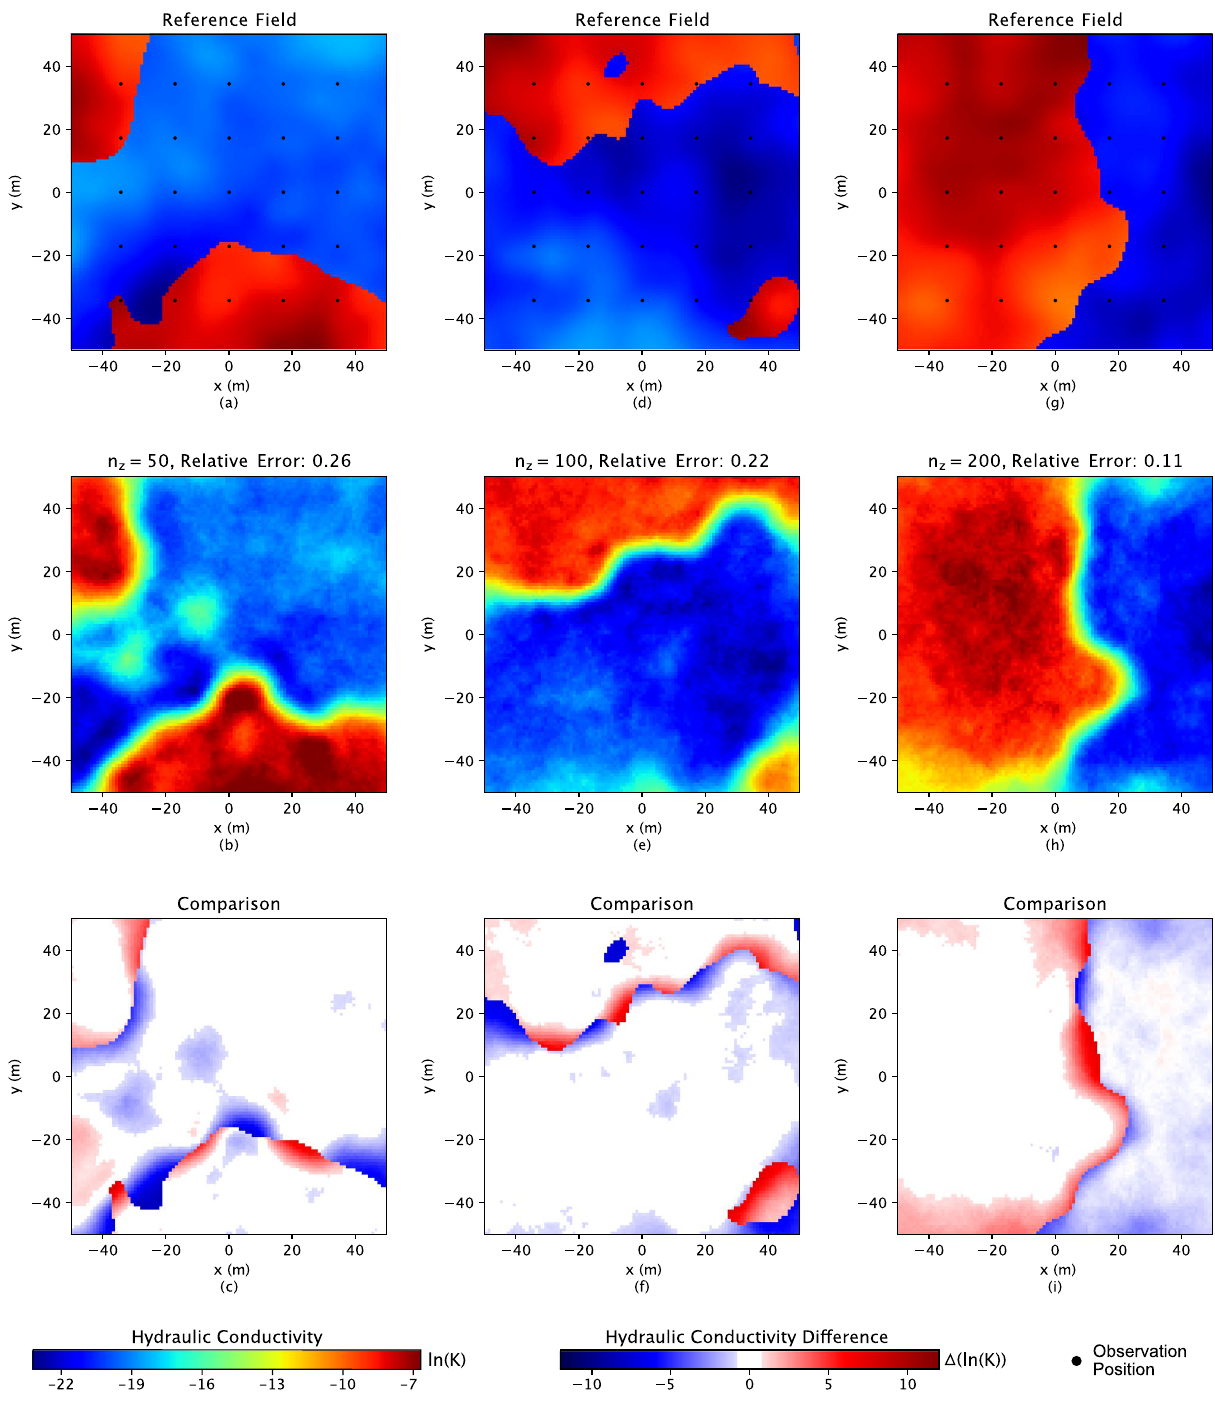
Figure 4. Three bimodal reference conductivity fields are shown in subfigures ( a ), ( d ), and ( g ). The black dots in the first row represent the 5 × 5 regular grids for observation points. The corresponding inverse results are shown in the second row, subfigures ( b ), ( e ), and ( h ). The hydraulic conductivity shows on the ln scale. The relative errors above inverse figures represent the difference between related reference and simulation figures. The last row shows the difference between the related reference fields and the inverse